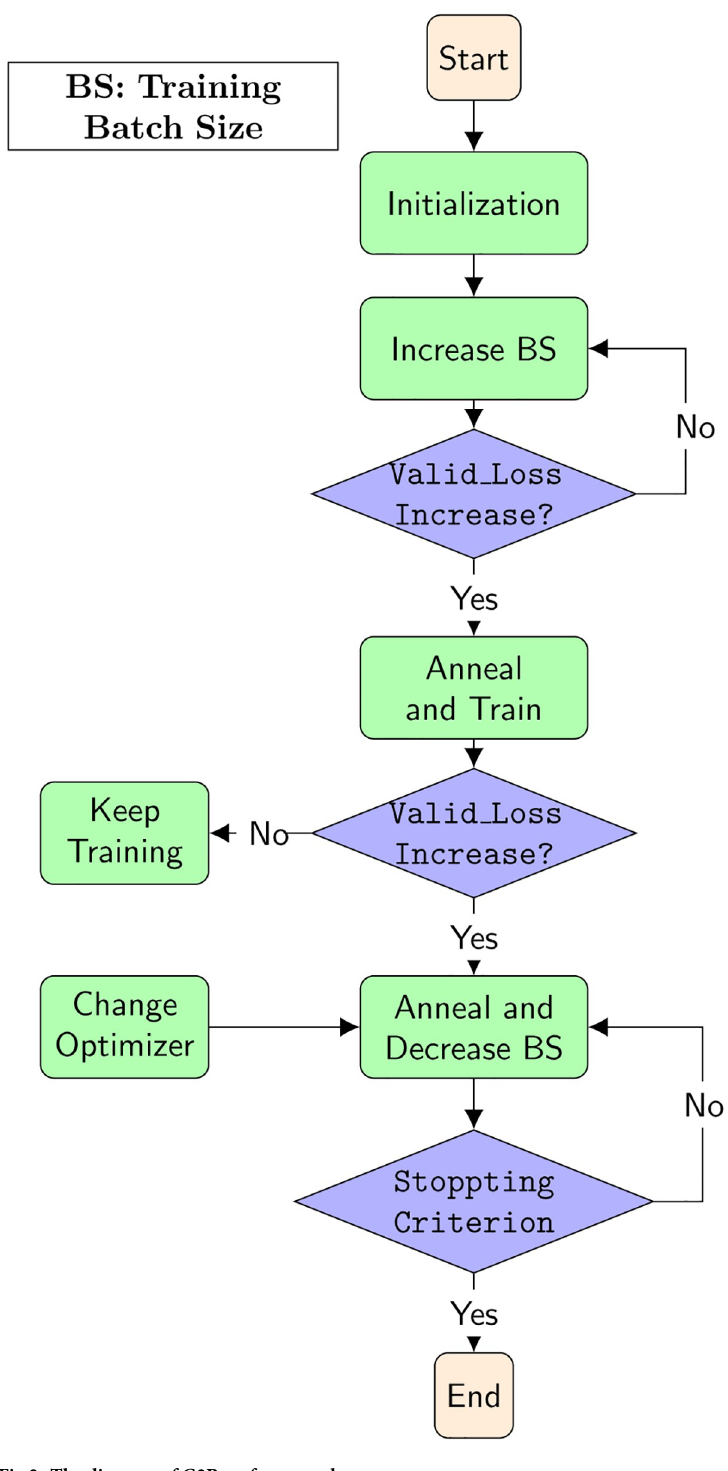
Fig 2. The diagram of G2Basy